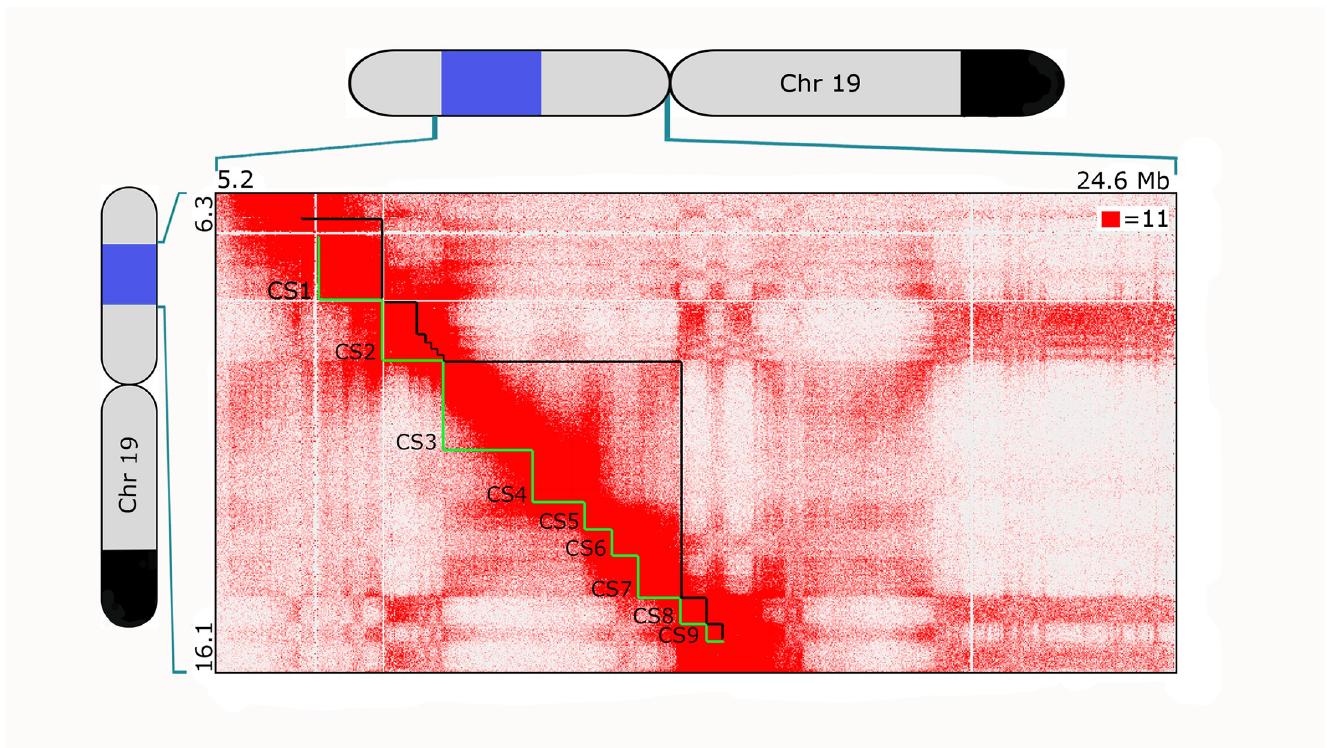
Fig 4. In situ Hi-C map of CS1-9 in PGP1f. Hi-C map of region including CS1-9, displayed at 25 kb resolution. (See Methods for data processing and normalization.) Contact count indicated by the color of each pixel, ranging from 0 (white) to 11 (red); OligoSTORM steps (CS1-9) delineated in green below the diagonal, and compartmental intervals delineated in black above the diagonal. Cartoons of chromosome 19 show extent of the 8.16 Mb imaged region (blue) and block of SNVs shared between PGP1 and PGP95 (black; as in Fig 1B).